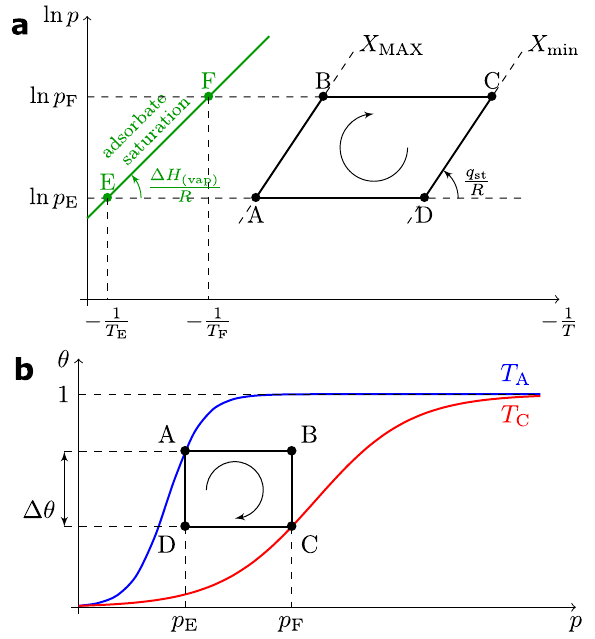
Fig. 10 Schematics of ideal adsorption/desorption thermal energy storage cycle. a Ideal cycle in the Clapeyron chart. b Same ideal cycle in the coverage-pressure chart, between the two limiting isotherms passing by θ ( p , T A ) and θ ( p , T C